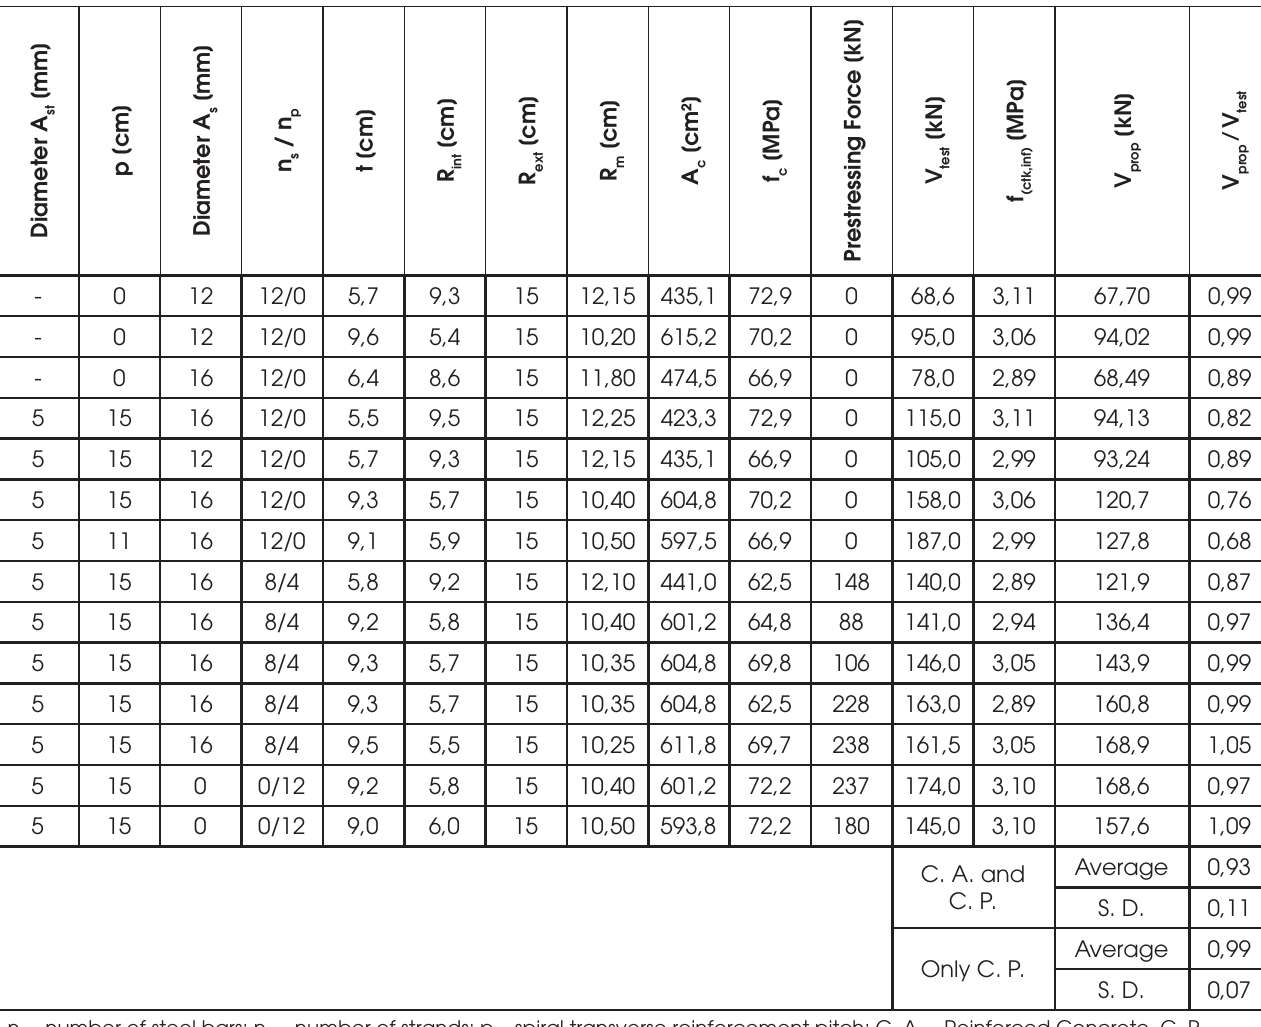
Comparison between the experimental test from Völgyi et al. [27] and proposed